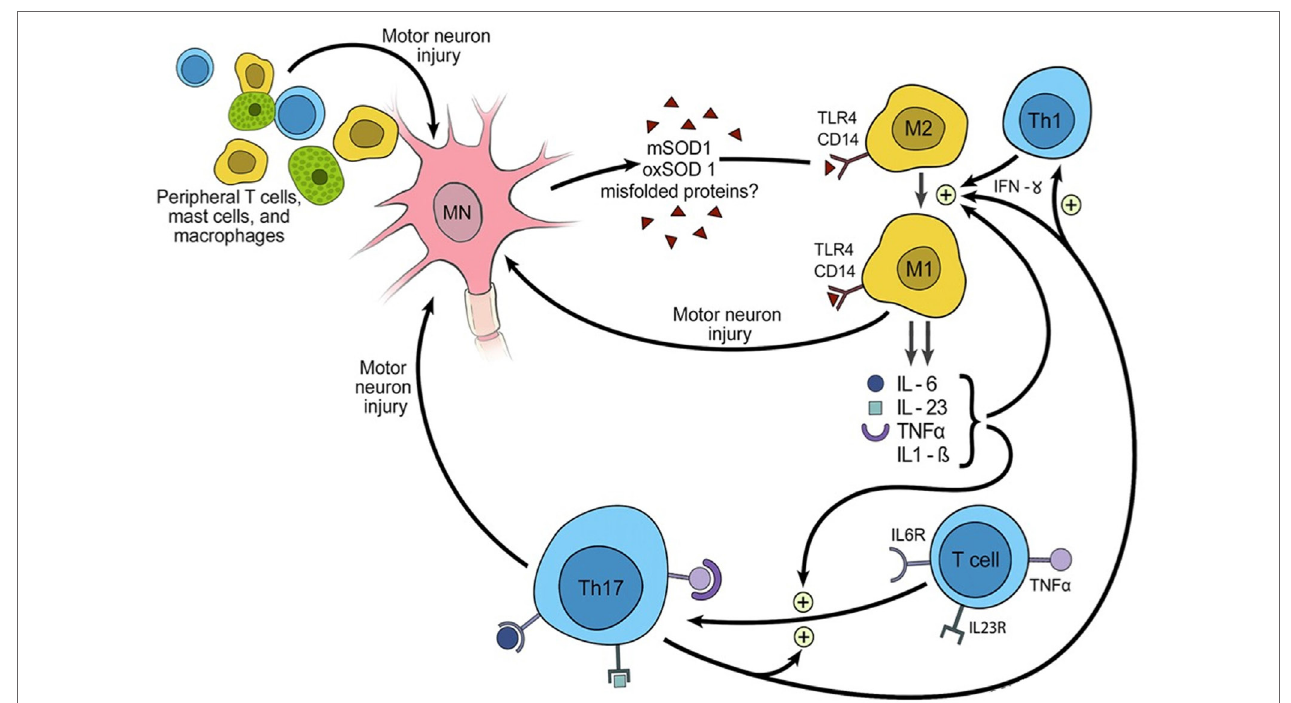
FigURe 2 | Triggering of inflammation and the role of inflammation in propagating amyotrophic lateral